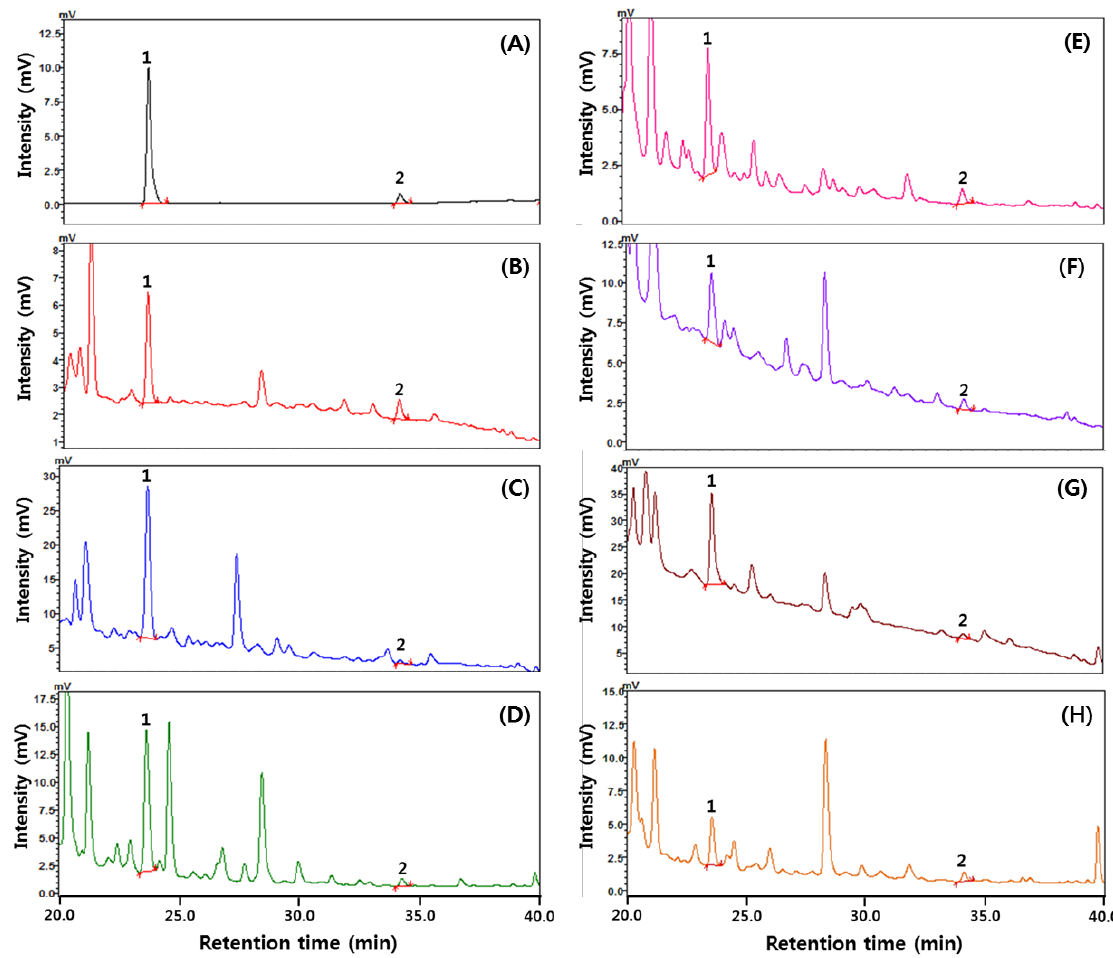
Figure 1. HPLC chromatograms of diacetyl in fruit wines: ( A ) standards of 1 mg/L; ( B ) maesil wine; ( C ) black raspberry wine; ( D ) peach wine; ( E ) apple wine; ( F ) plum wine; ( G ) red grape wine; ( H ) white grape wine. Peak 1, diacetyl; Peak 2, 2,3-hexanedione (IS).